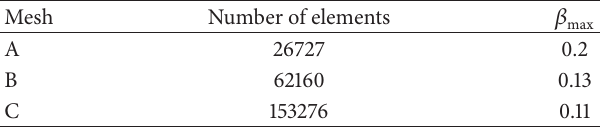
Table 1: Mesh sensitivity analysis data.